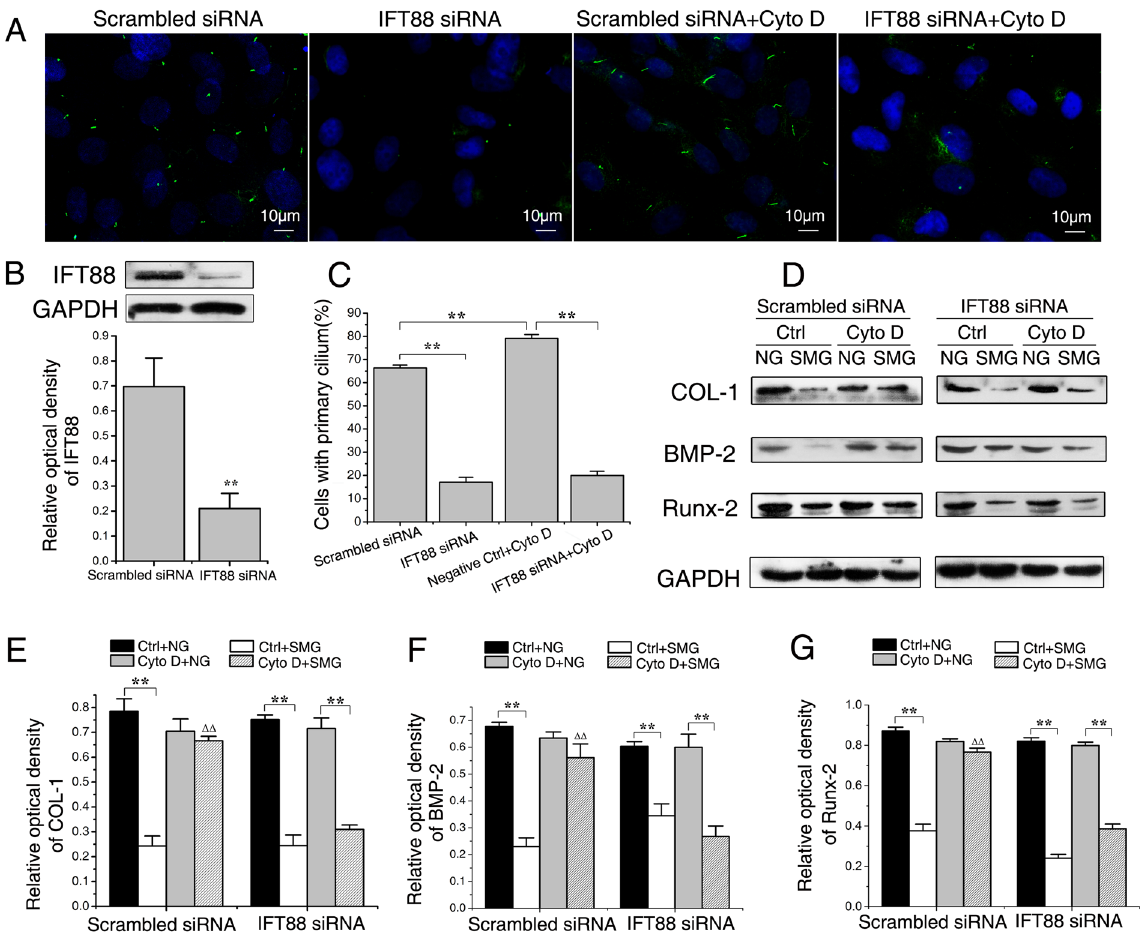
Figure 8. Intraflagellar transport protein 88 (IFT88) siRNA knockdown inhibits the ability of cytochalasin D (Cyto D) to counteract the reduction of osteogenesis. ( A ) Immunofluorescence image of rat calvarial osteoblasts (ROBs) treated with or without IFT88 siRNA and 0.1 μ M Cyto D. Primary cilia were stained with acetylated α -tubulin (green), and DNA were stained with DAPI (blue). ( B ) Treatment with IFT88 siRNA resulted in significant decreases in IFT88 expression at the protein levels. ( C ) Quantification of the percentage of cells with a cilium in each group. ( D ) Representative Western blot detecting expression of osteogenesis markers COL- I, BMP-2 and Runx-2 (with GAPDH as a control) in each group. ( E - G ) The protein levels of COL-I, BMP-2 and Runx-2 in each group. NG: normal ground, SMG: simulated microgravity. Full-length Western blots are presented in Supplementary Figures 6 and 7. Each experiment was conducted at least three times